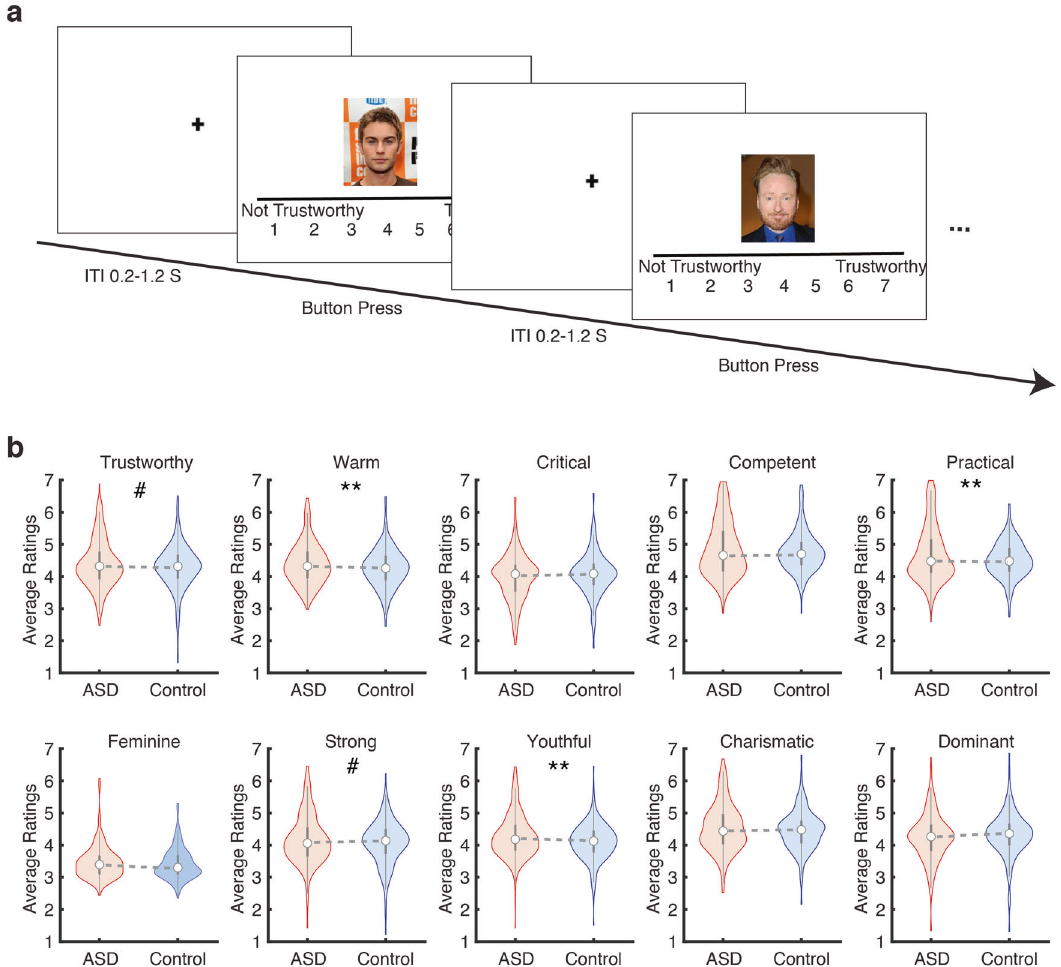
Fig. 3 Procedure of the face judgment task and behavioral results. a Sample trials of the face judgment task. b Distributions of trait ratings across groups. Violin plots present the median value as the white circle and the interquartile range as the gray vertical bars. ** p < 0.01, *** p < judgments (Fig. 3b): trustworthiness (unpaired two-tailed t -test, t (640) = 1.80, p = 0.07), warm ( t (640) = 2.75, p = 0.006), practical ( t (640) = 3.09, p = 0.002), strong ( t (640) = 1.71, p = 0.09), and